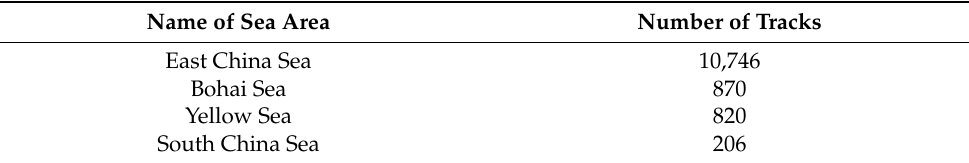
Table 4. Statistics on the number of ports in the sea area.